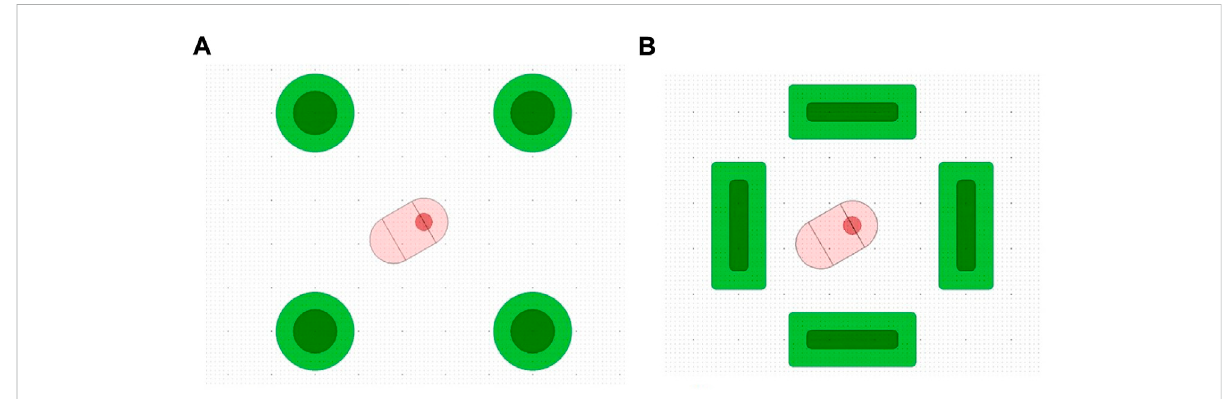
FIGURE 5 Top view of two cell types: (A) both n-doped (in red) and p-doped (in green) columnar electrode cell, and (B) n-type columnar and p-type trench electrode